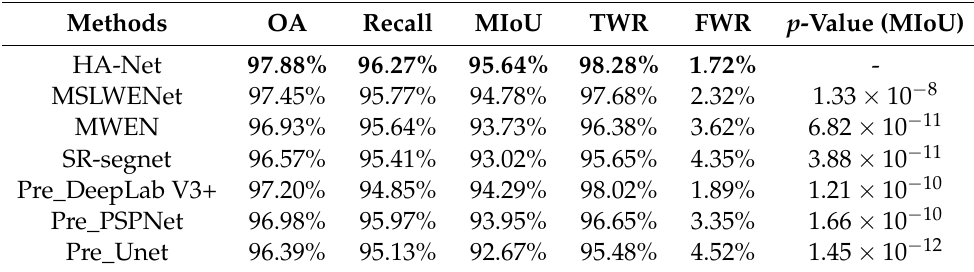
Table 4. The quantitative results of comparing the proposed method against other methods within the region of Figure